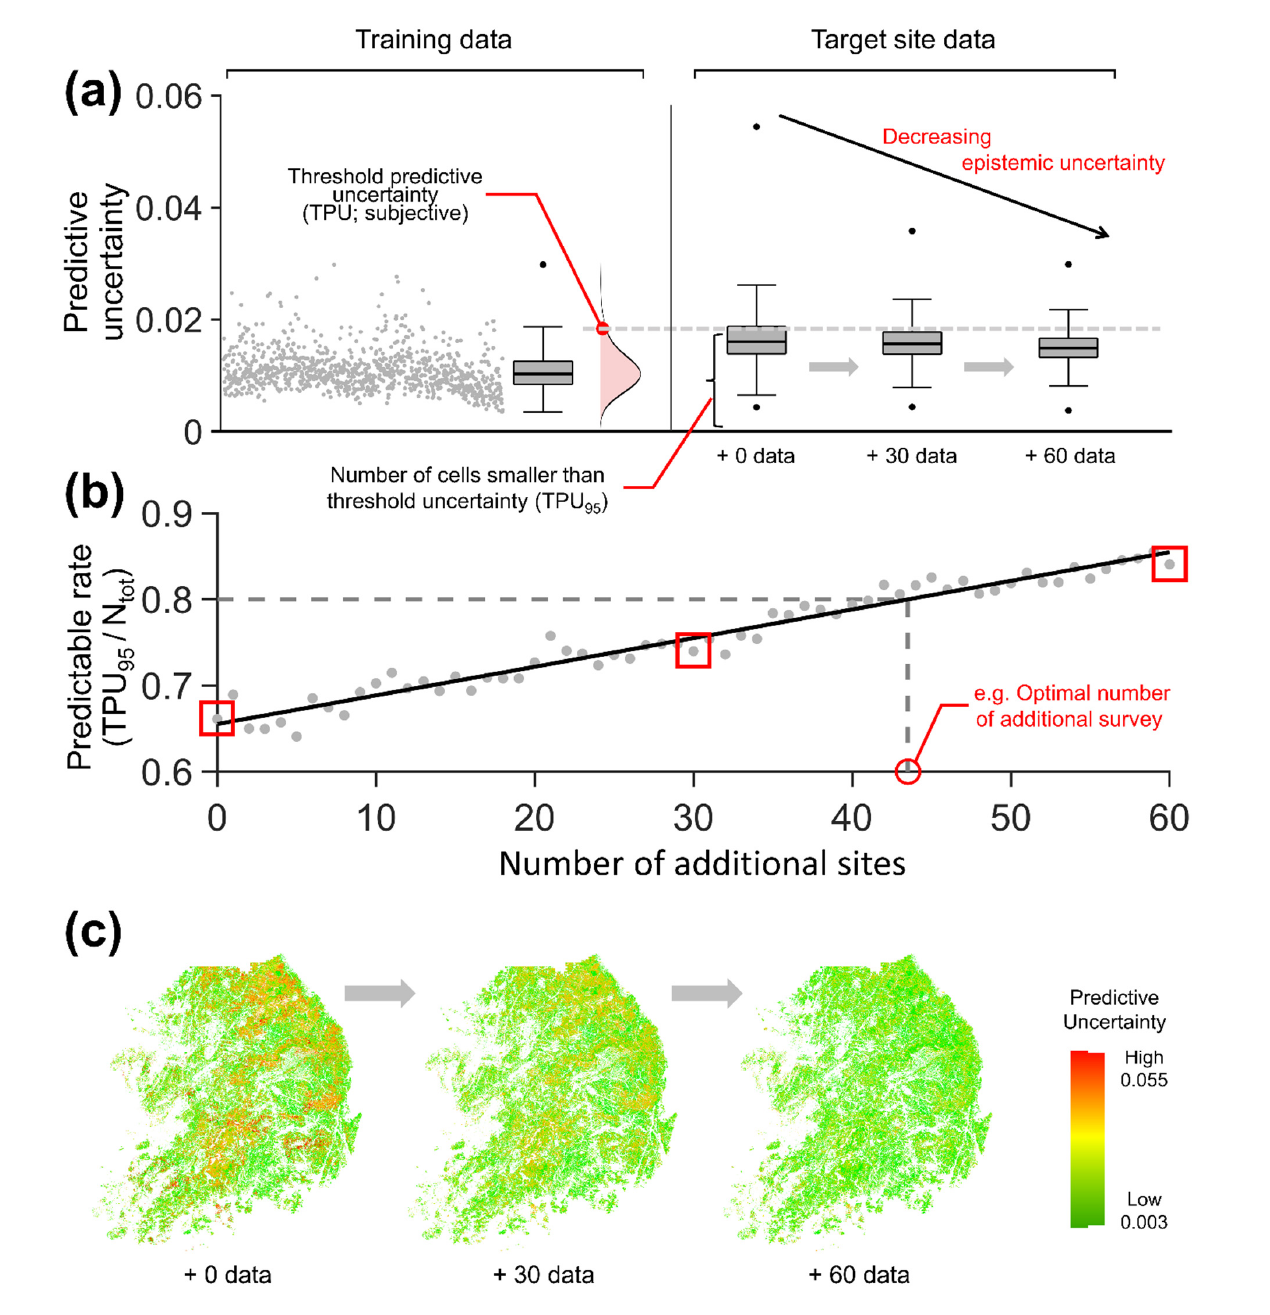
Figure 9. Selecting optimal sampling sites to strengthen the DSM of South Korea using the optimal sampling algorithm suggested in this study. A predictive model was developed with 953 training data items. ( a ) Threshold predictive uncertainty was determined by the distribution of the predictive uncertainty when using the training data as input to the developed model. Epistemic uncertainty decreased with the addition of training data. We do not show all outliers in the box plot, and only the maximum and minimum values of the dataset are indicated. ( b ) The predictable rate in- creased according to the number of additional sites, which helped to confirm the optimal number of additional survey sites. ( c ) Expected results of the spatial distribution of predictive uncertainty in South Korea are shown when 30 and 60 data items are collected using the optimal sampling algo- rithm. N tot , number of grid cells in the target site.